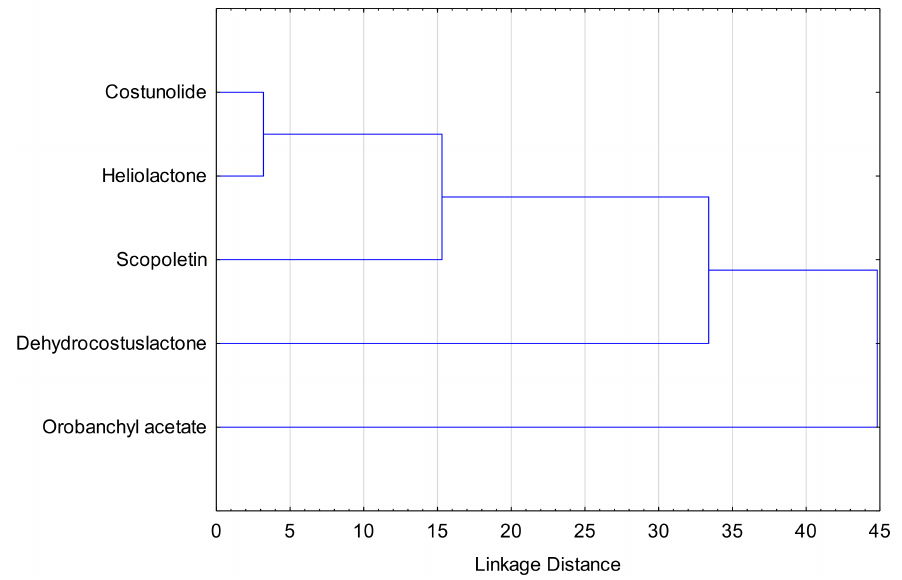
Figure 7. Cluster analysis for the compounds based on their concentration in sunflower exudates of all varieties.